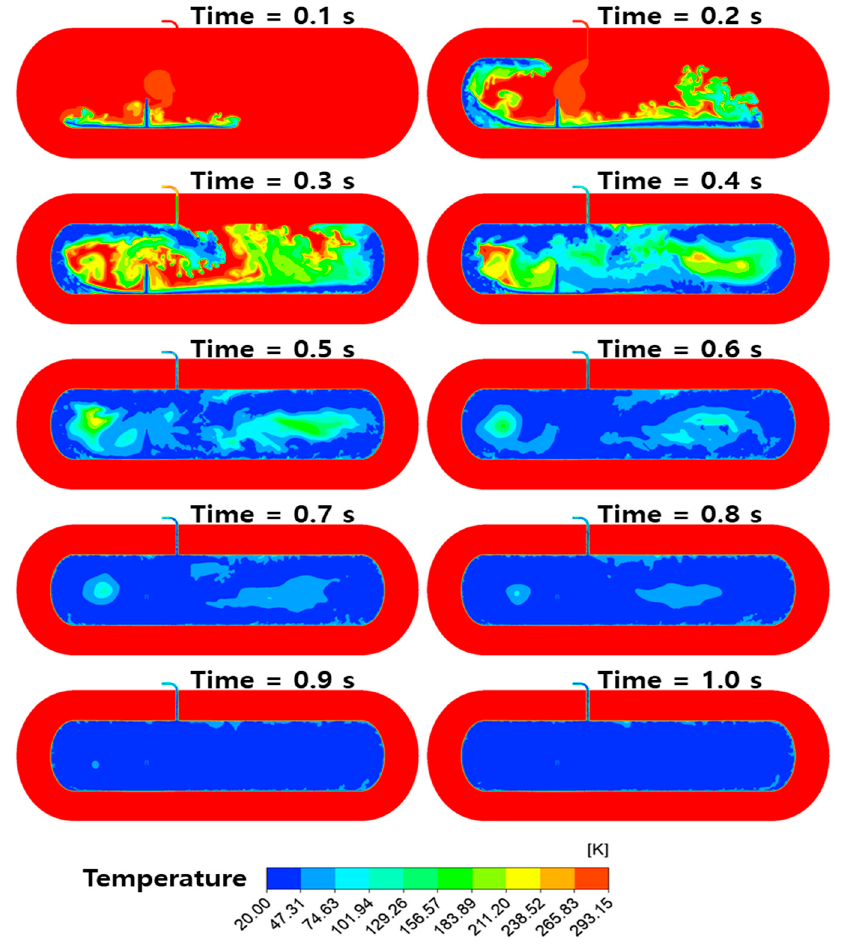
Figure 11. Distributions of temperature according to charging process.